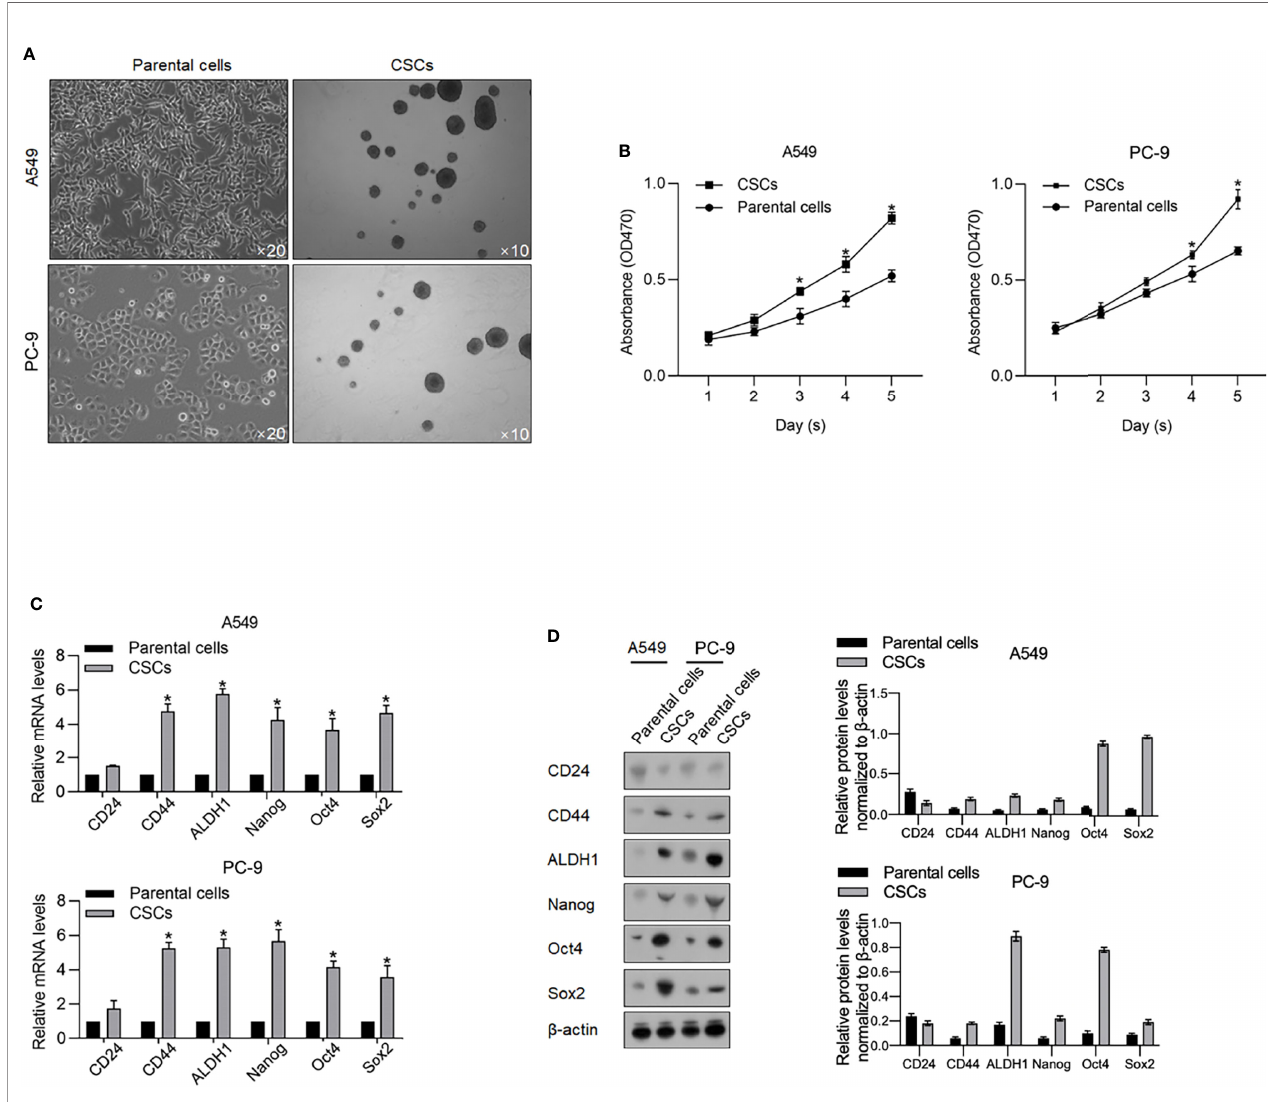
FIGURE 1 | Enrichment of CSCs from A549 and PC-9 cells. (A) After being cultured in a serum-free medium, spheres derived from A549 and PC-9 were imaged at an ampli fi cation of ×10. (B) By performing CCK-8 assay, the cell viability of CSCs and their parental cells from days 1 to 5 was measured. * p < 0.05 vs. the parental cell group. The mRNA (C) and protein levels (D) of stemness hallmarkers, including CD24, CD44, ALDH1, Nanog, Oct4, and Sox2 were measured by performing RT-qPCR and Western blot analysis. * p < 0.05 vs. parental cell